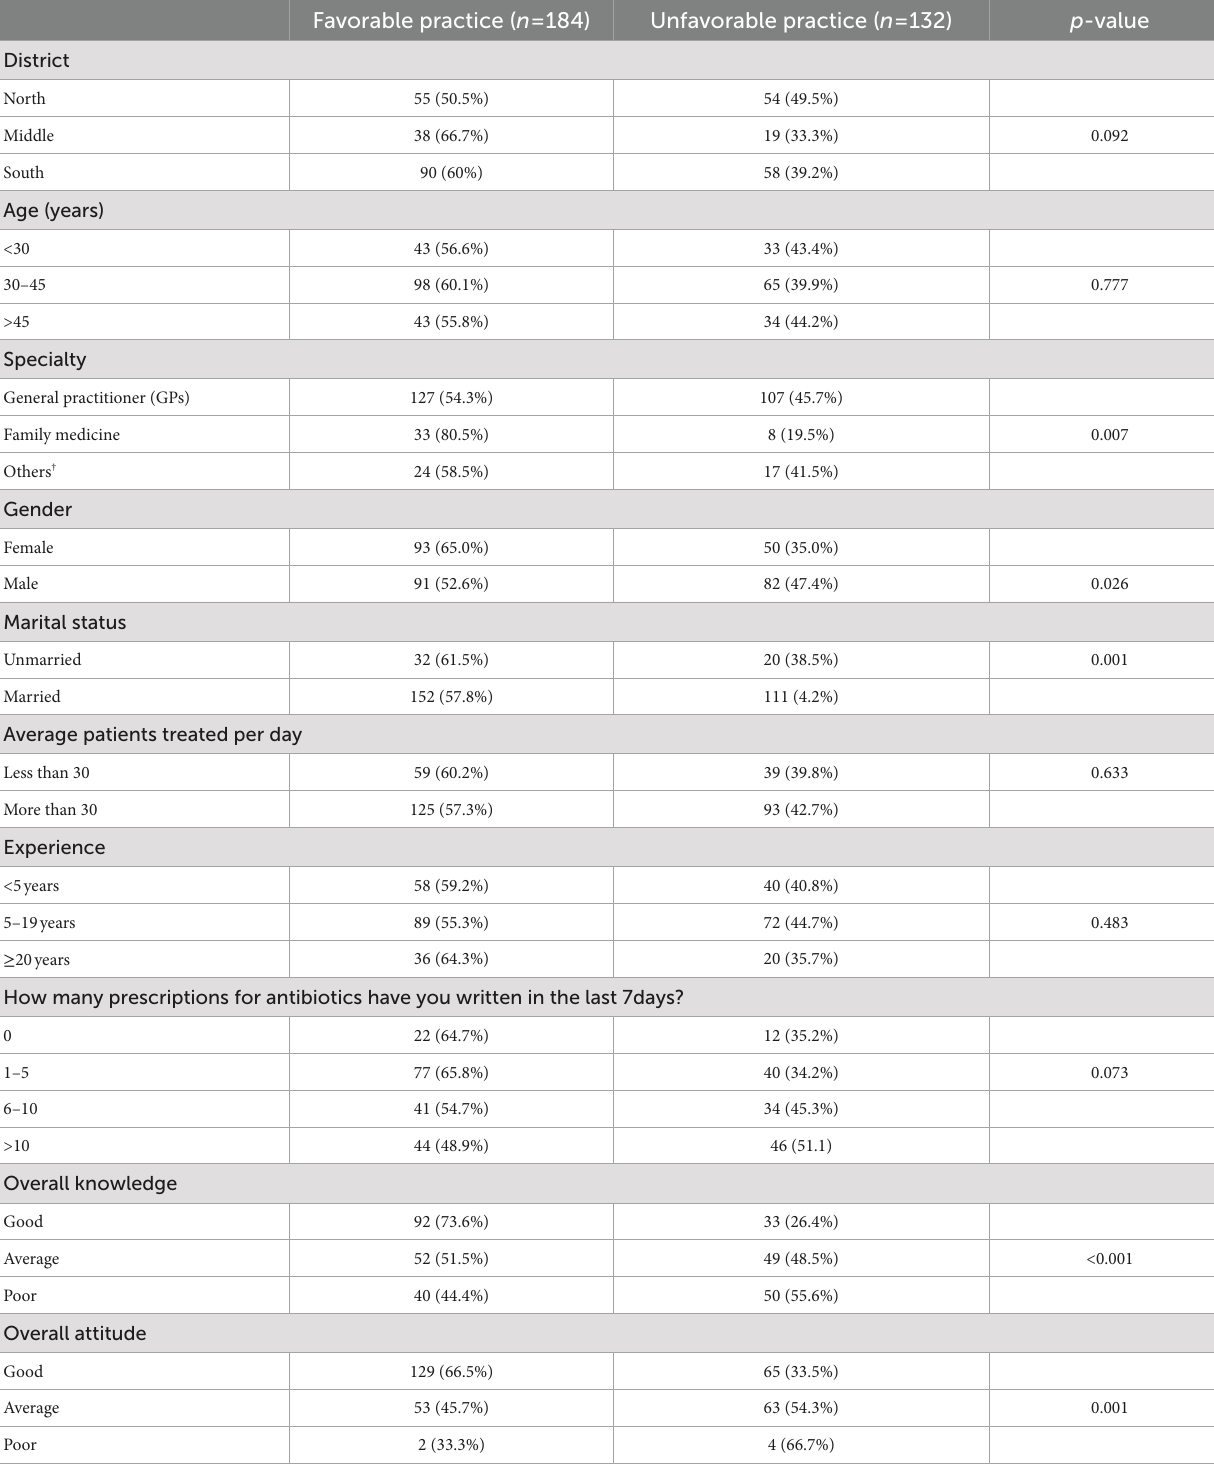
TABLE 5 Determinants of favorable